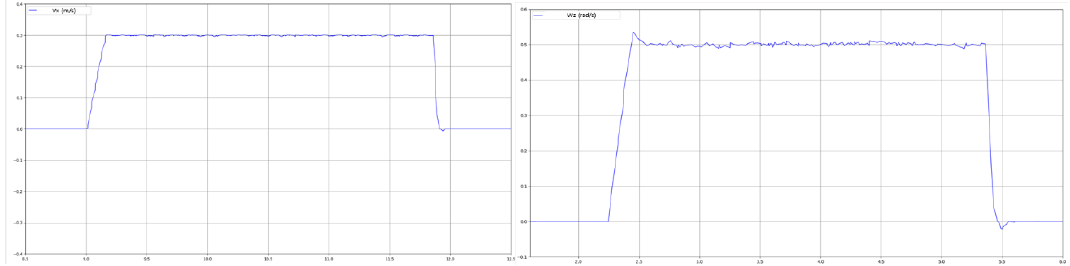
Figure 5. Practical response of the forward velocity and angular velocity.